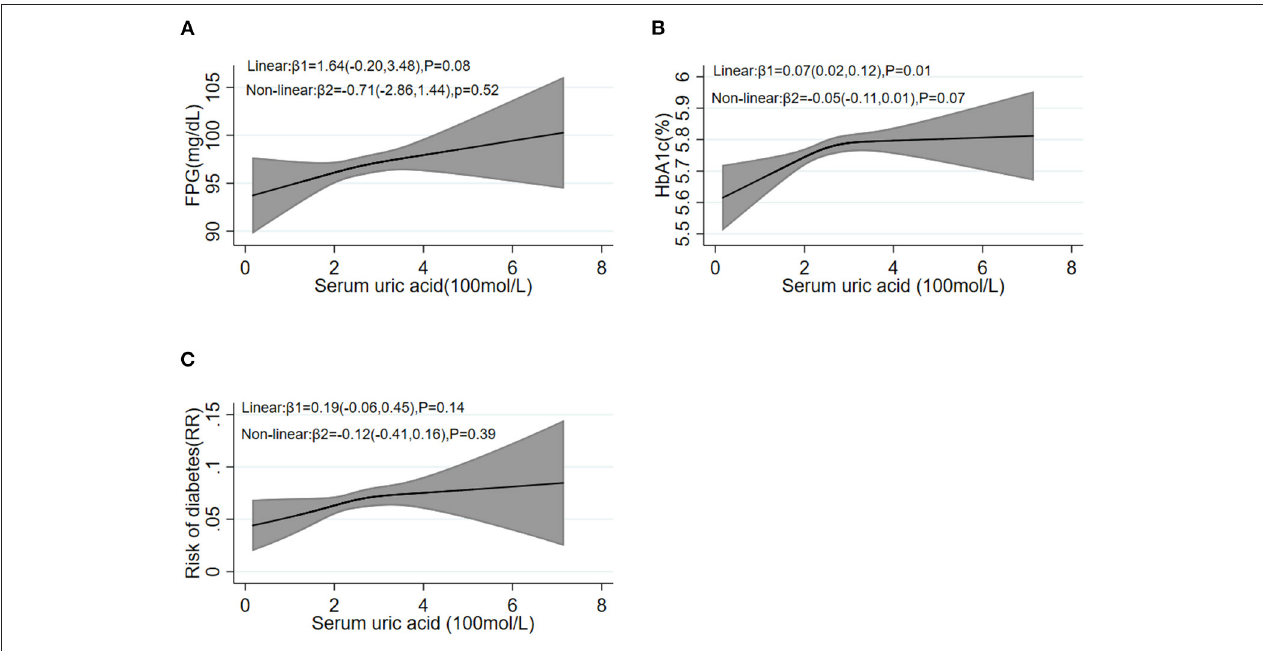
FIGURE 2 | Restricted cubic spline analysis between baseline SUA levels and follow-up FPG (A) , HbA1c (B) , and the risk of diabetes (C) . FPG, fasting plasma glucose; HbA1c, hemoglobin A1c.